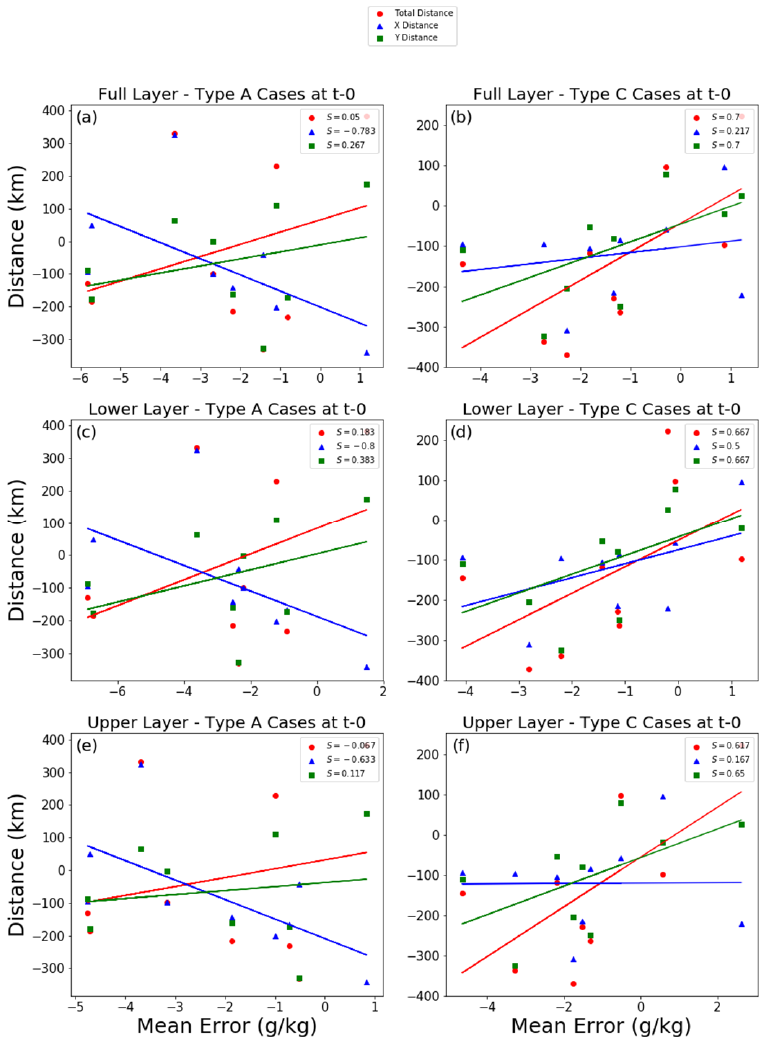
Figure 3. Scatterplots representing the correlations and their statistical significance for the WRF700mb-inflow region utilizing the YSU scheme. Specific humidity mean error is represented on the x-axis in g kg − 1 and distance values on the y-axis are in km. Red circles represent the displacement error for MCS initiation locations, the blue triangles are their X-components of displacement, and the green squares Y-components of displacement. Spearman rank correlation coefficients are in the top-right corner with a line of best fit added to demonstrate the correlation behavior. ( a ) Full Layer-Type A Cases at t-0; ( b ) Full Layer-Type C Cases at t-0; ( c ) Lower Layer-Type A Cases at t-0; ( d ) Lower Layer -Type C Cases at t-0; ( e )Upper Layer-Type A Cases at t-0; ( f ) Upper Layer-Type C Cases at t-0.